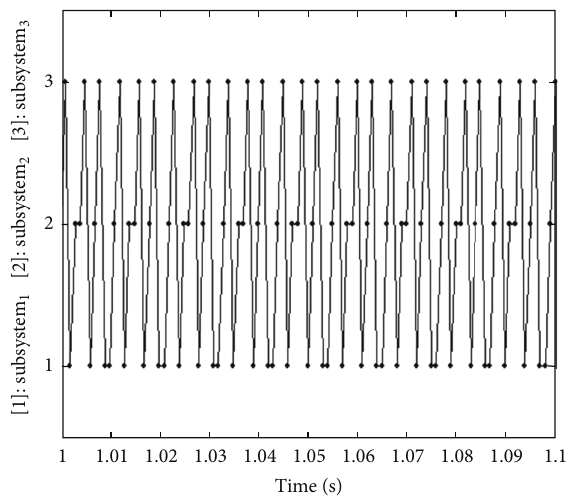
Figure 3: The switching times of the system during [1, 1.1]